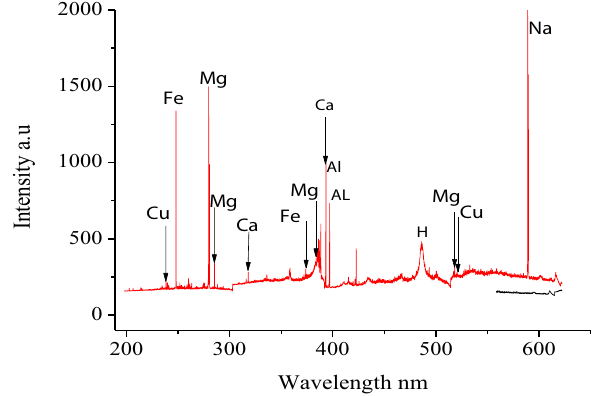
Figure 2. Example of LIBS spectrum of Oyster (NIST 1566B) tissue.